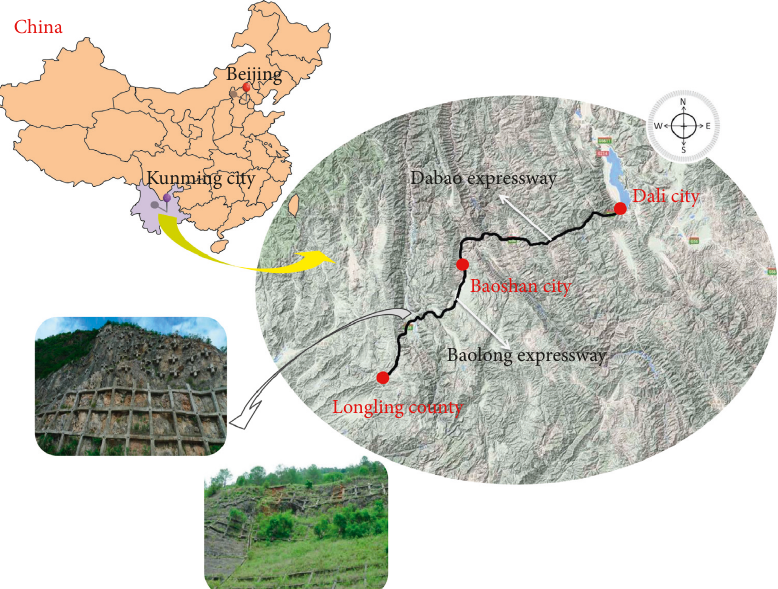
Figure 1: Location map of the study area.